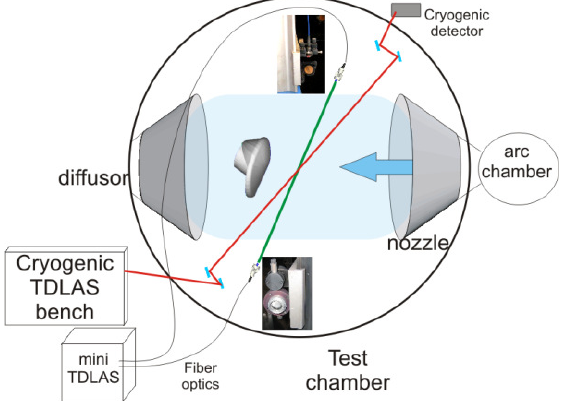
Figure 8. TDLAS setup experiment in the F4 wind